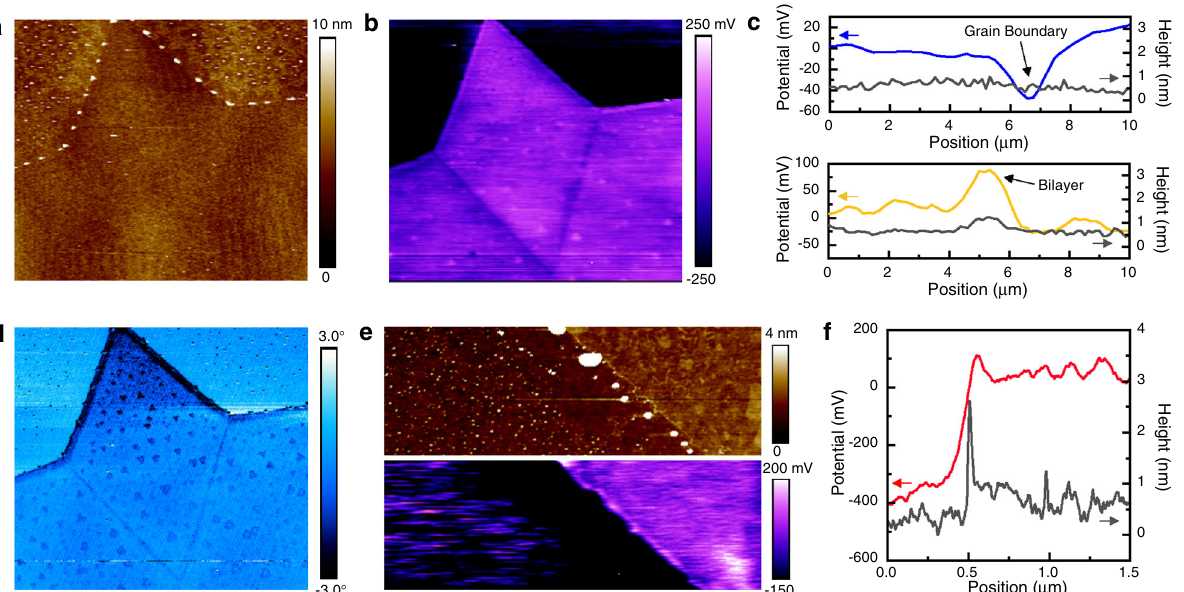
Fig. 2 Kelvin probe force microscopy characterization of a MoSe 2 monolayer fl ake region. a Topography AFM image, b KPFM potential map with scale bars equal to 5 μ m, c line scans of edge grain boundary (blue line in b ) and bilayer (yellow line in b ) with associated height scans, d KPFM phase map with scale bars equal to 5 μ m, e height and KPFM potential of enhanced edge of new fl ake with scale bar equivalent to 1 μ m, and f line scans of height and potential in e